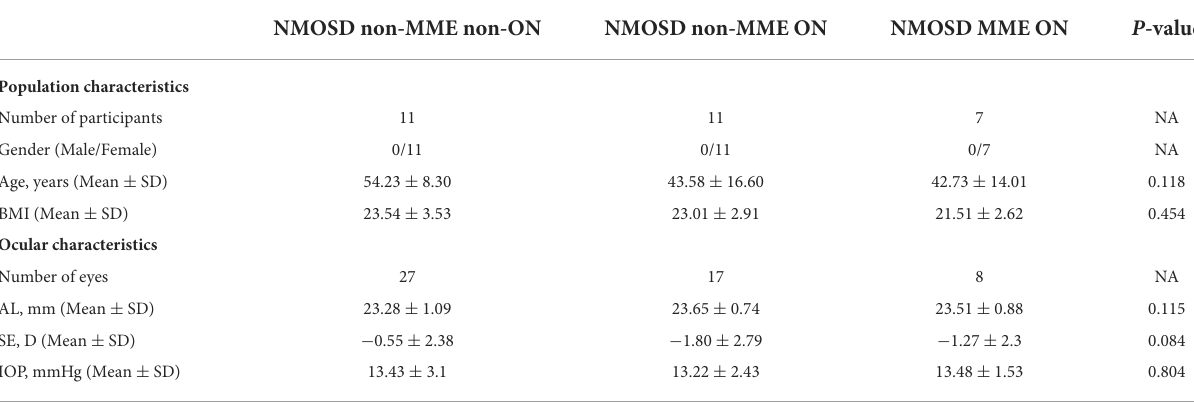
TABLE 1 Population, ocular demographics, and clinical summary. NMOSD non-MME non-ON NMOSD non-MME ON NMOSD MME ON P